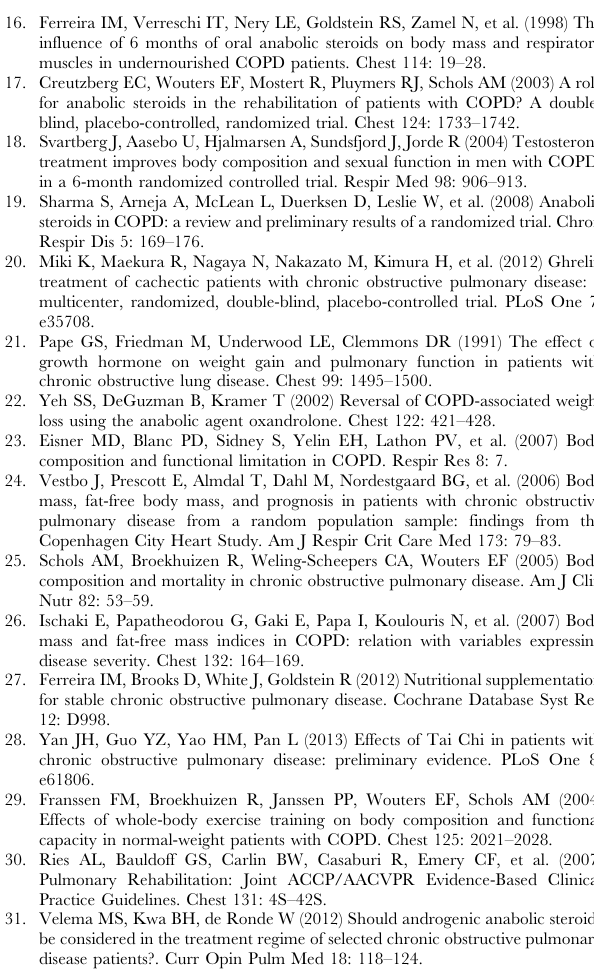
Figure S1 PRISMA 2009 Flow diagram of study selec-